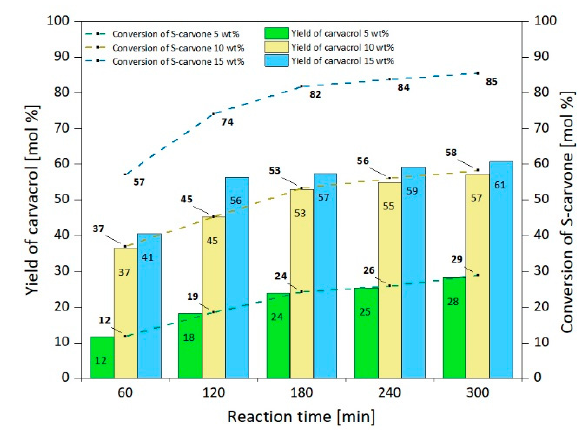
Figure 14. Influence of the reaction time and catalyst content on the conversion of S-carvone and the yield of carvacrol at 200 °C. (The experimental error was 1 mol%.)